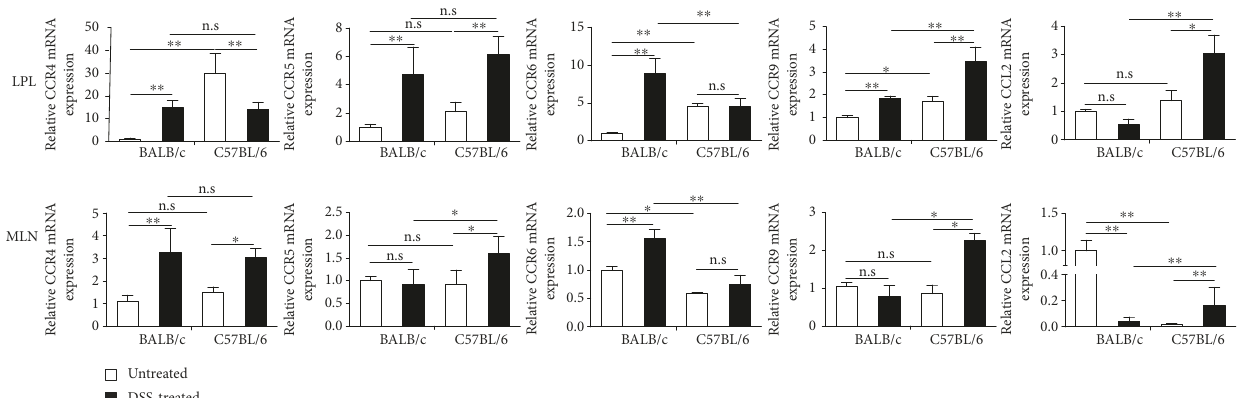
Figure 6: RT-PCR analysis of chemokine mRNA expression in LPLs and MLNs in acute DSS colitis in C57BL/6 and BALB/c mice. Levels of mRNA were normalized to β -actin mRNA and presented relative to levels observed in unchallenged BALB/c mice. Data indicate mean ± SD obtained from an experiment involving four animals and representative of two independent experiments. Statistical di ff erences were evaluated by Student ’ s t -test. ∗ p < 0 05 ; ∗∗ p < 0 01 . In all assays, the physical (day 0) cell number of immune cell subtypes is